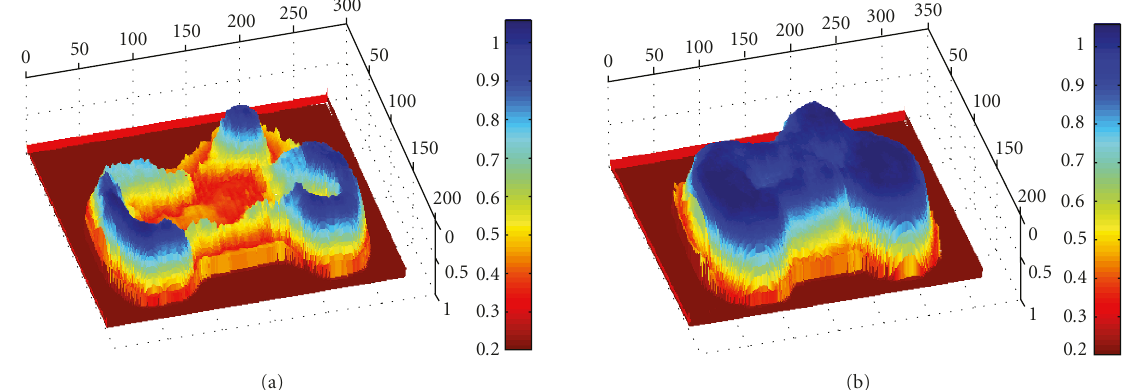
Figure 9: Mean volume image for the most relevant detected landmarks on the set of Caltech motorbike database for gray saliency (a) and our proposed CSR (b).